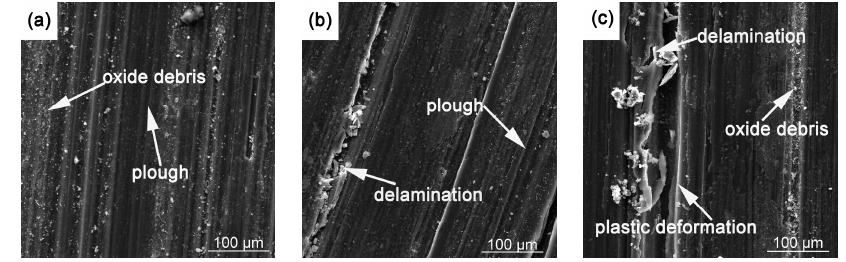
Figure 17. the worn surface of AZ91-1.0%Pr alloys with T6 heat treatment under different loads ( a ) 30 N; ( b ) 60 N; ( c ) 90 N.